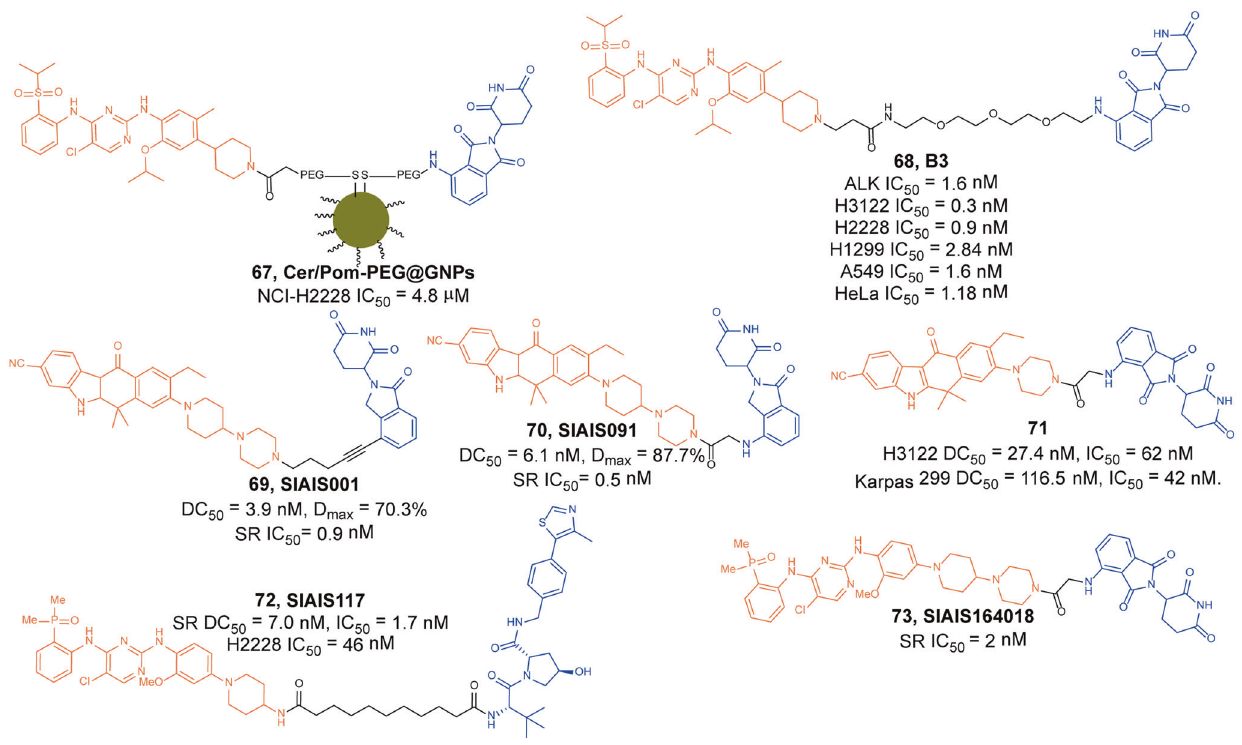
the phosphoinositide 3-kinase (PI3K) signaling cascade and a key regulator of critical cellular processes, including proliferation, survival, and metabolism. Hyperactivation of AKT, due to gain-of- function mutations or ampli fi cation of oncogenes (receptor tyrosine kinases and PI3K) or inactivation of tumor suppressor genes (PTEN, INPP4B, and PHLPP), is one of the most common molecular perturbations in cancer and promotes malignant phenotypes associated with tumor initiation and progression. 118 Thus, AKT is an attractive therapeutic target. In 2020, Toker group described a degrader 64 ( INY-03-041 , inhibited AKT1, AKT2, and AKT3 with the IC 50 values of 2.0 nM, 6.8 nM, and 3.5 nM, respectively, while the IC 50 values of